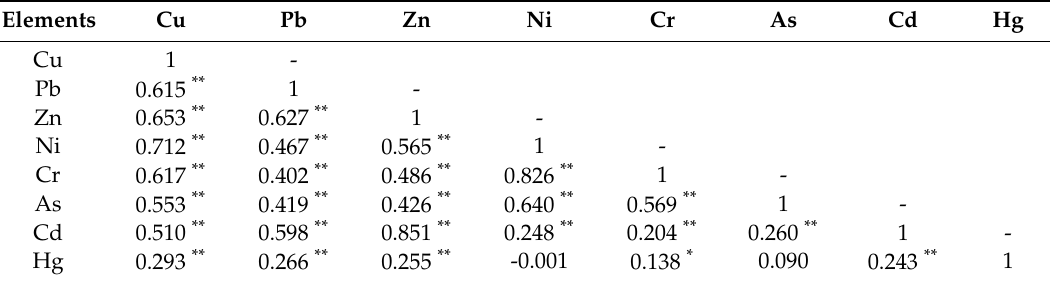
Table 6. The correlation analysis matrix of trace metal(loid)s in the study area.